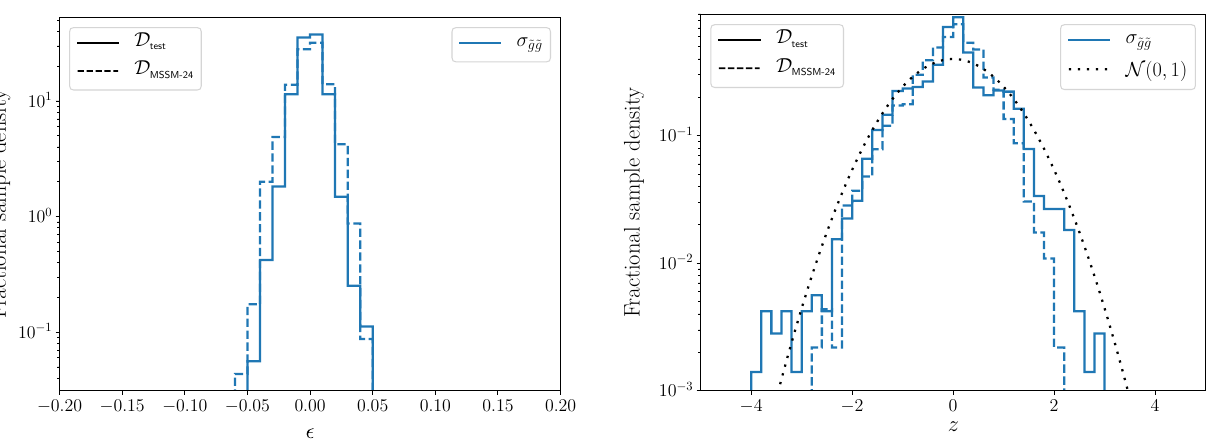
Fig. 7 The relative error (left) and residual (right) distributions for the sampledfromtheMSSM-24usingflatpriorsfortheMSSMparameters. gluino pair-production cross-section in the test sets D test (solid) and All distributions are normalised to unity. The unit normal distribution D D is shown for comparison as a dotted black line test are sampled from the MSSM-24 (dashed). The input points in same distribution as the training set, while the points in D MSSM-24 are